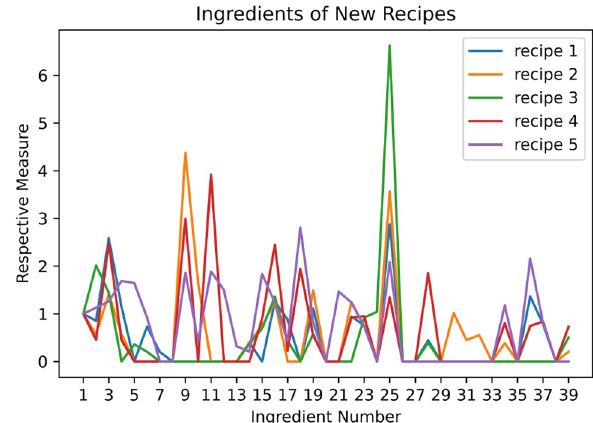
Fig. 10 Ingredients of generated new recipes